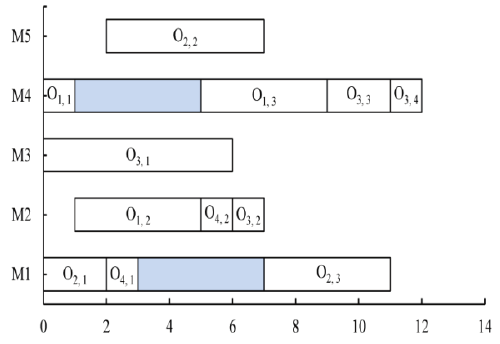
Fig. 4 Optimal Solution for 4x5 instance ( f